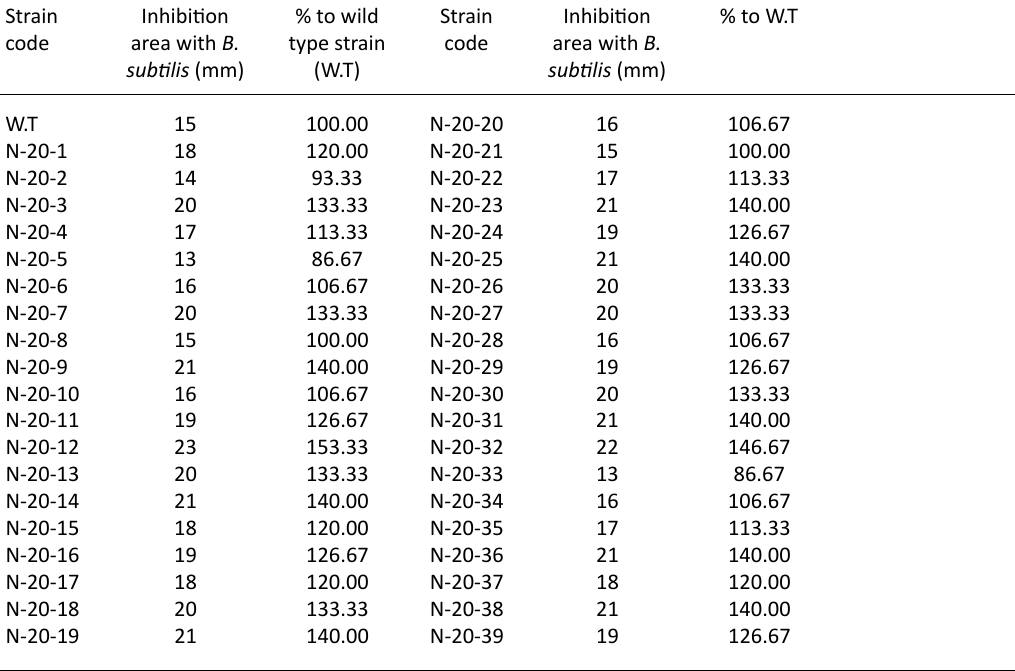
Table 3. Neomycin production of different mutants obtained under 1.75 mg/ml neomycin stress and treatment of S. albogriseolus with 100 µg/ml NTG for 20 min Strain Inhibition % to wild Strain Inhibition % to W.T code area with B. type strain code area with B. subtilis (mm) (W.T) subtilis